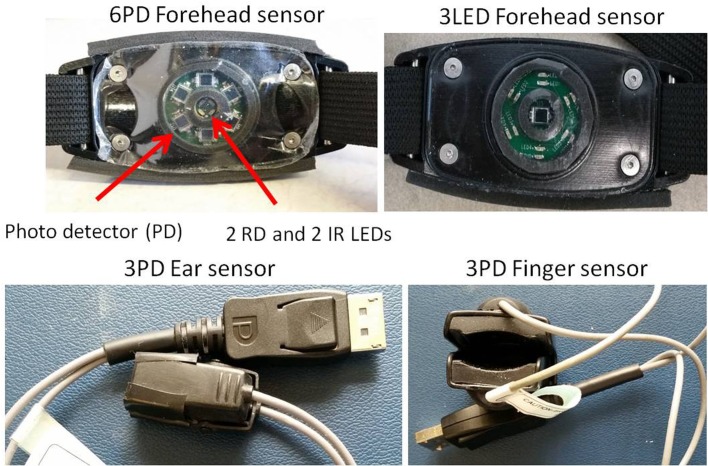
Multichannel POs.